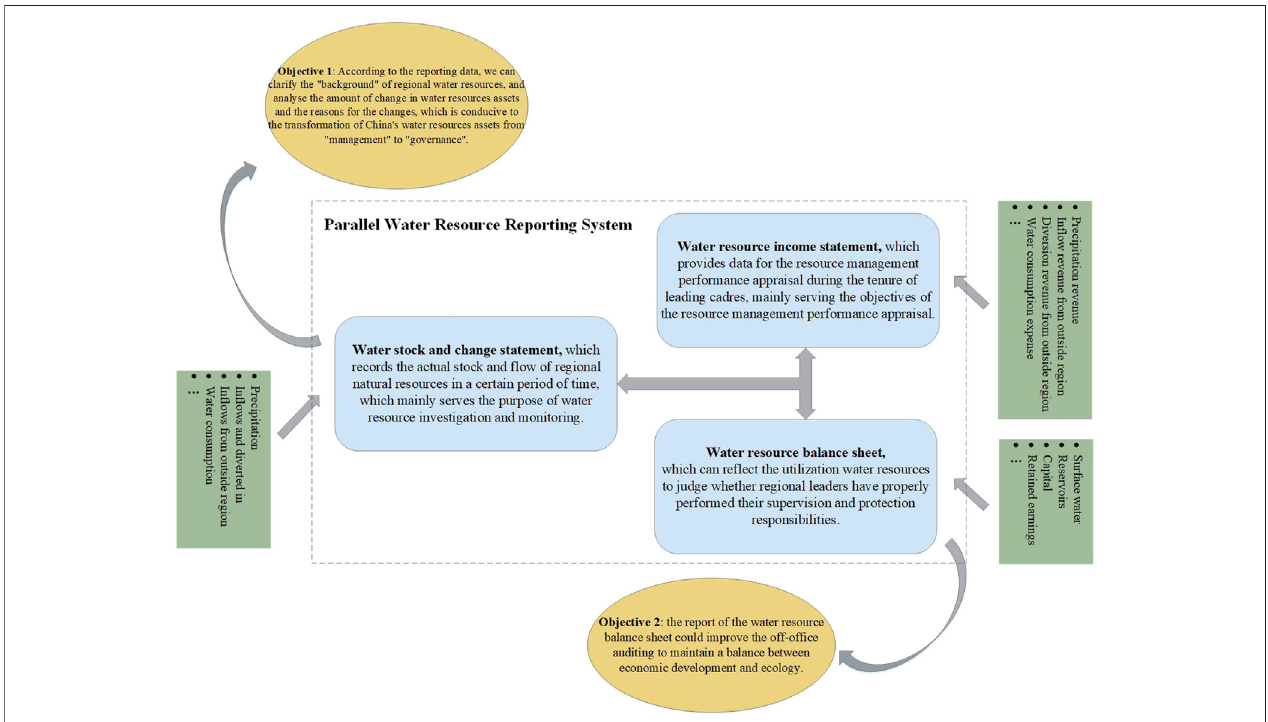
FIGURE 1 | Framework of parallel water resource reporting